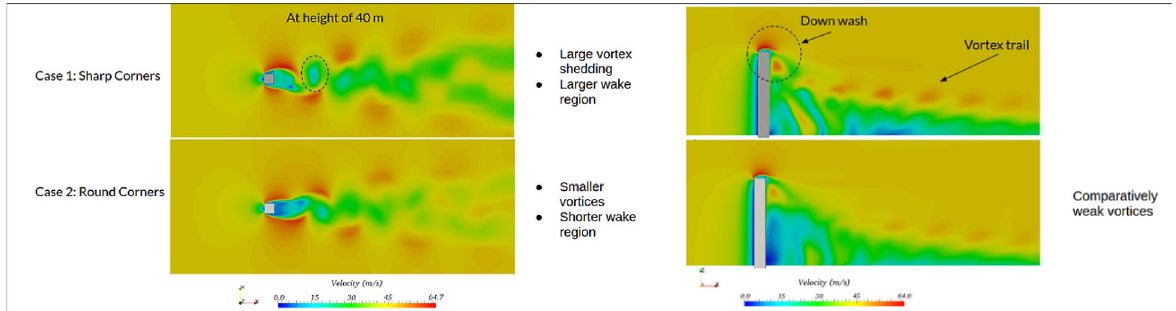
Fig. 9 Wind Load Calculation on a Building with Computational Fluid Dynamics (CFD) (Source:) See Foot note link 3